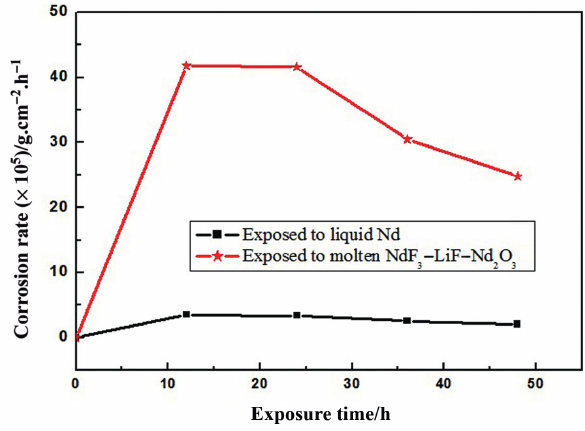
Figure 4: Relation between corrosion rate and exposure time for TiB 2 /TiC